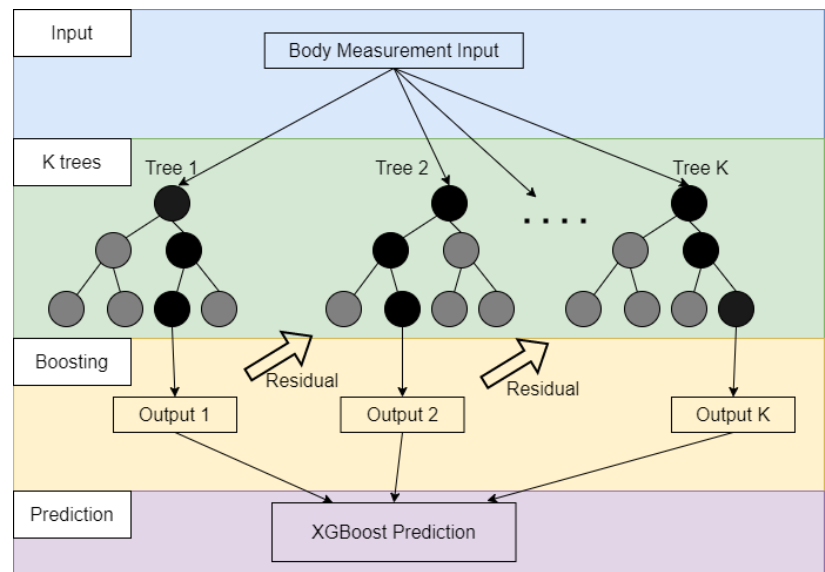
Figure 4. Generic representations of XGBoost